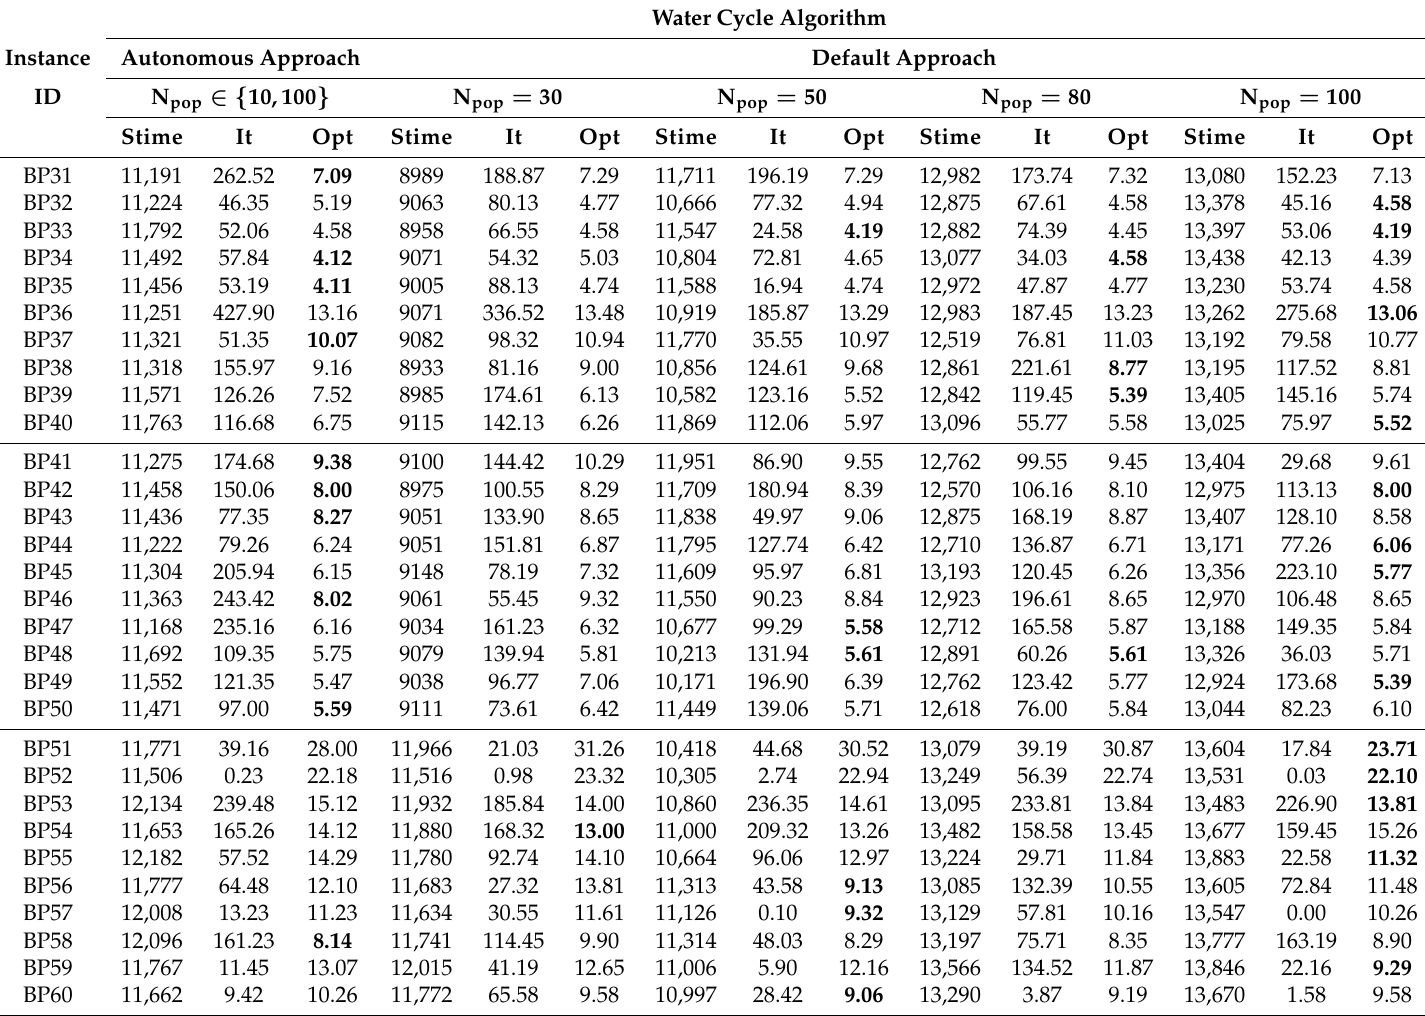
Table 7. Results solving the Boctor’s instances (2/3). Water Cycle